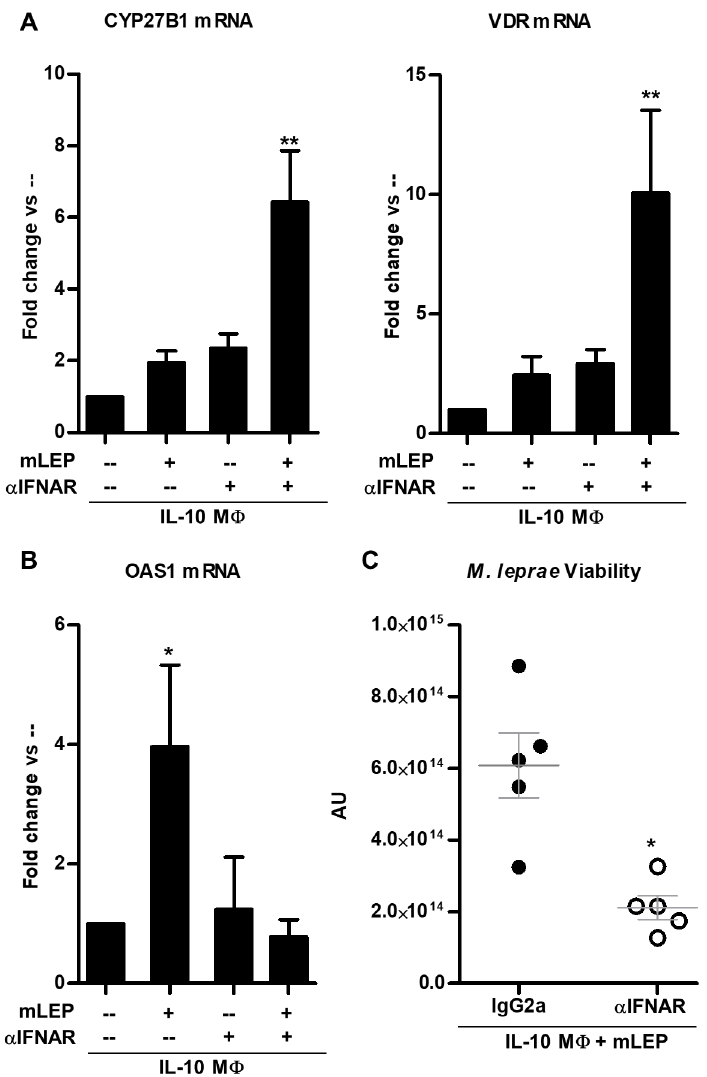
Fig 5. Blocking type I IFN signaling during M . leprae infection of IL-10 M F reduces bacterial viability. IL-10 M F were pre-treated with either antibody against the type I IFN receptor, IFNAR, or isotype control then infected with M . leprae at an MOI of 10 for 24 hours. ( A ) CYP27B1, VDR, and ( B ) OAS1 gene expression levels were measured using qPCR. Data are shown as mean ± SEM, n < 5. ( C ) IL-10 M F were infected with M . leprae and co-treated with IFNAR neutralizing monoclonal antibody, or isotype control for 5 days under vitamin D-sufficient conditions. The ratio of M . leprae 16S RNA to RLEP DNA was calculated as a measurement of bacterial viability. Statistical significance was determined using one-way ANOVA. ( (cid:3) p (cid:20) 0.05, (cid:3)(cid:3) p (cid:20) 0.01). subversion of the initial host response is critical to establishing infection [23]. Therefore, the ability of the invading pathogen to modulate the intrinsic macrophage response, such as antag- onizing TLR2 [24] or suppressing the vitamin D-dependent antimicrobial response, will lead to immunopathology. Here, we demonstrate that monocytes and M F have the capacity to trig- ger an intrinsic antimicrobial response during M . leprae infection in the absence of exogenous triggers (TLR2L or IFN- γ ), which is inhibited by the aberrant infection-induced expression of type I IFN. M . leprae may activate the intrinsic immune response in M F through a variety of pattern recognition receptors including TLR4, TLR9 and NOD2, but most importantly, TLR2